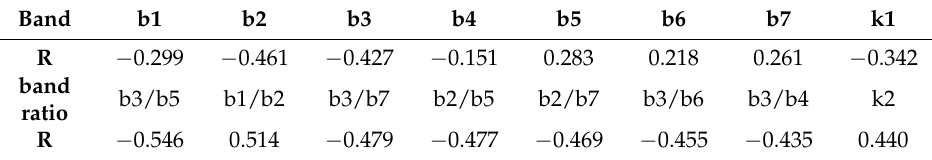
Table 2. Correlation coefficient between the radiance and the measured TLI.